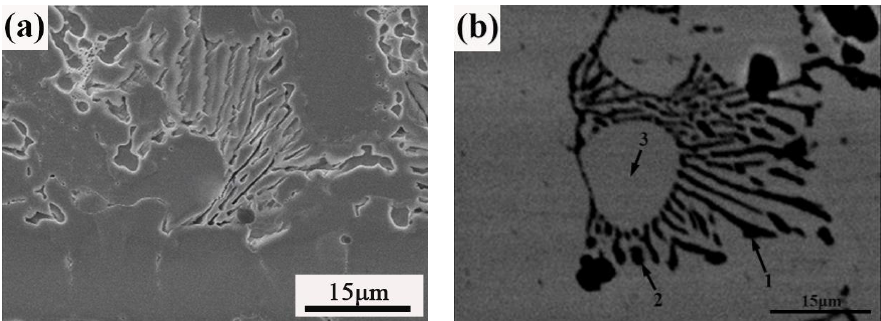
Figure 3. XRD patterns of the coatings.